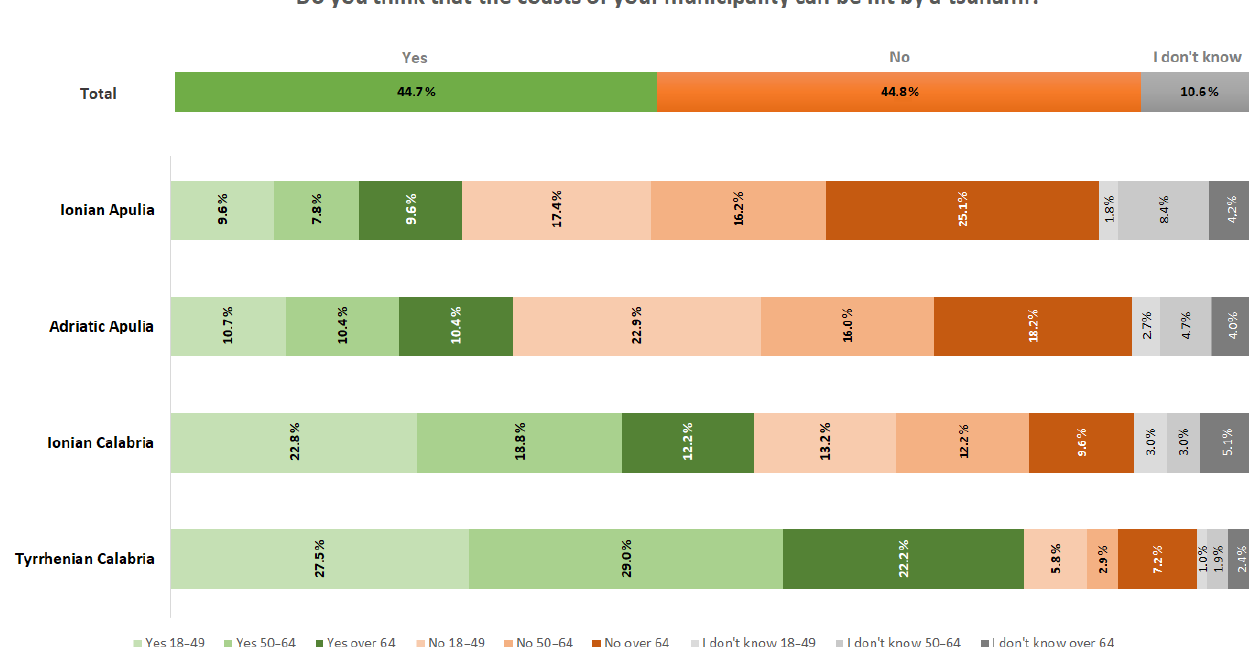
Figure 5. Comparison of the tsunami risk perception per coastal region and age